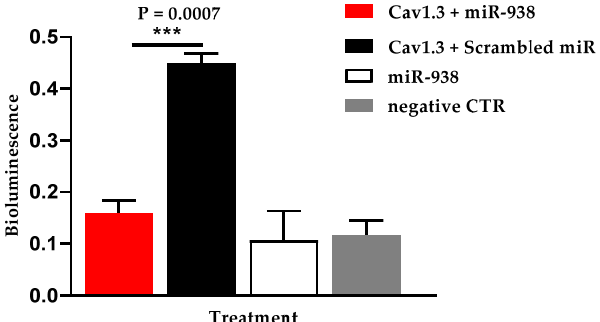
Figure 4. Luciferase bioluminescence after transfection of H9C2 cells with hsa-miR-938 and hsa-